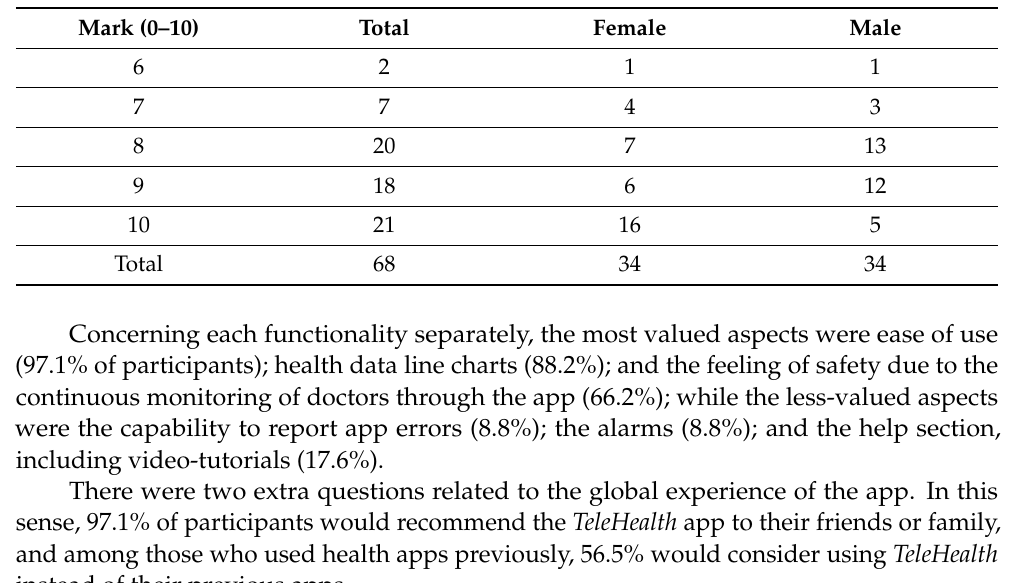
Table 5 details the results obtained. Table 5. Satisfaction of